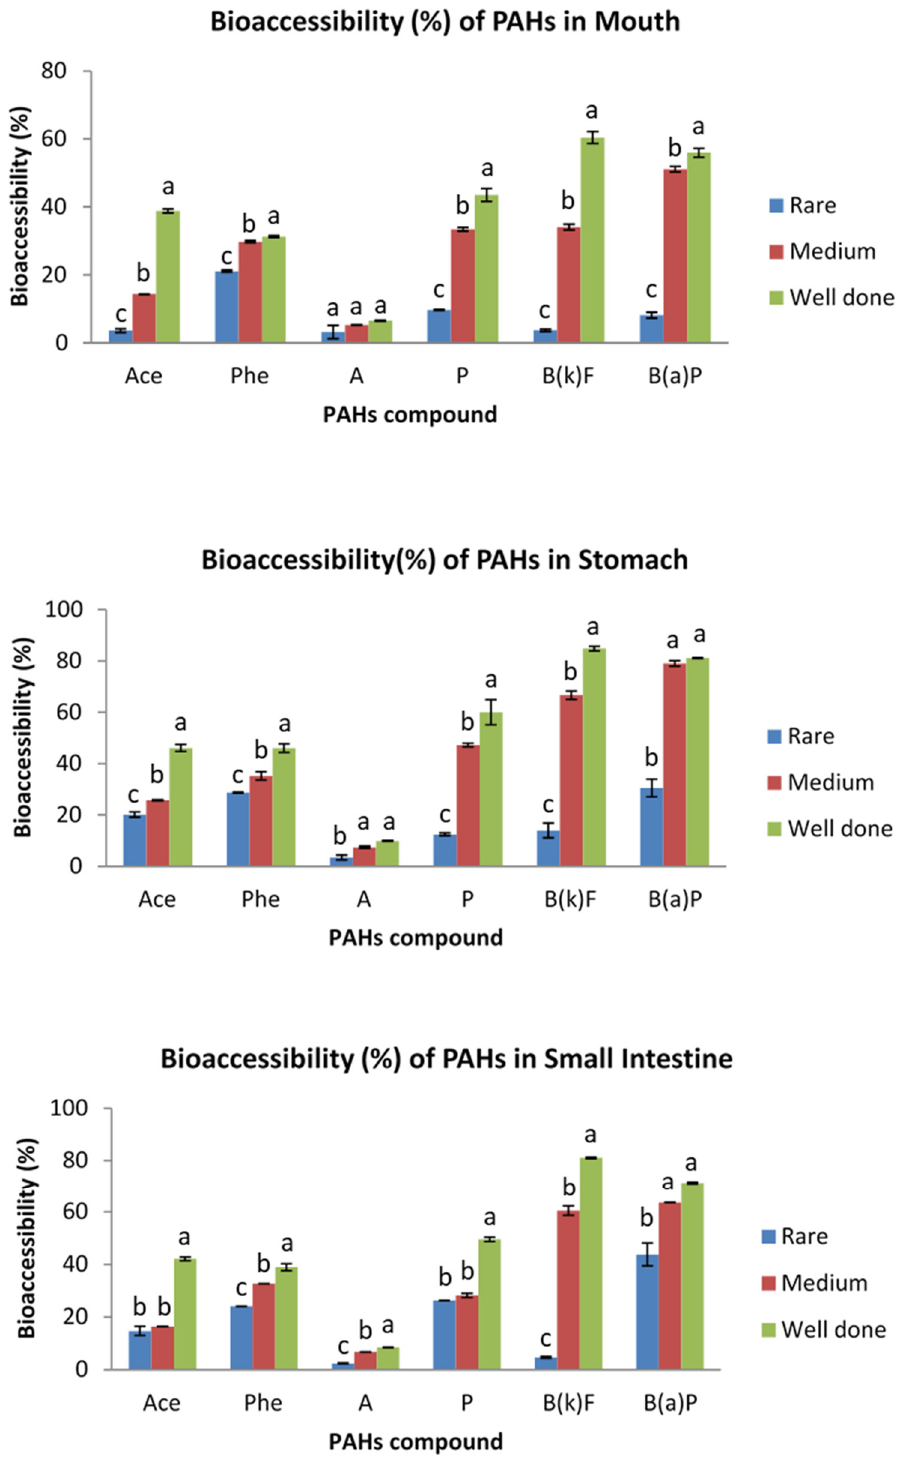
Figure 4. Bioaccessibility (%) of PAHs in grilled beef at different degrees of doneness in mouth, stomach and small intestine. Different letter indicates significant differences in bioavailability of PAHs in grilled beef of different doneness. Ace, acenaphthene; Phe, phenanthrene; A, anthracene; P, pyrene; B(k)F, benzo(k)fluoranthene; B(a)P, benzo(a)pyrene.